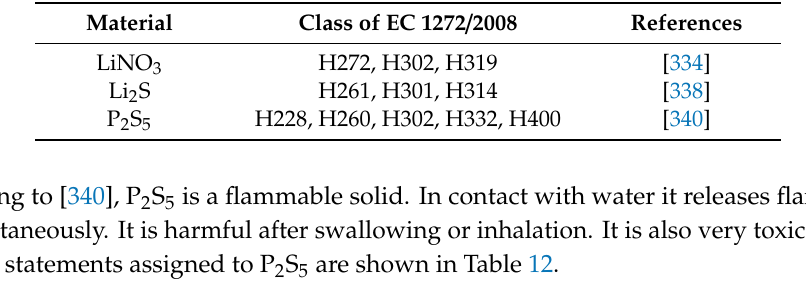
Table 12. Hazard statements of LiNO 3 , Li 2 S, and P 2 S 5